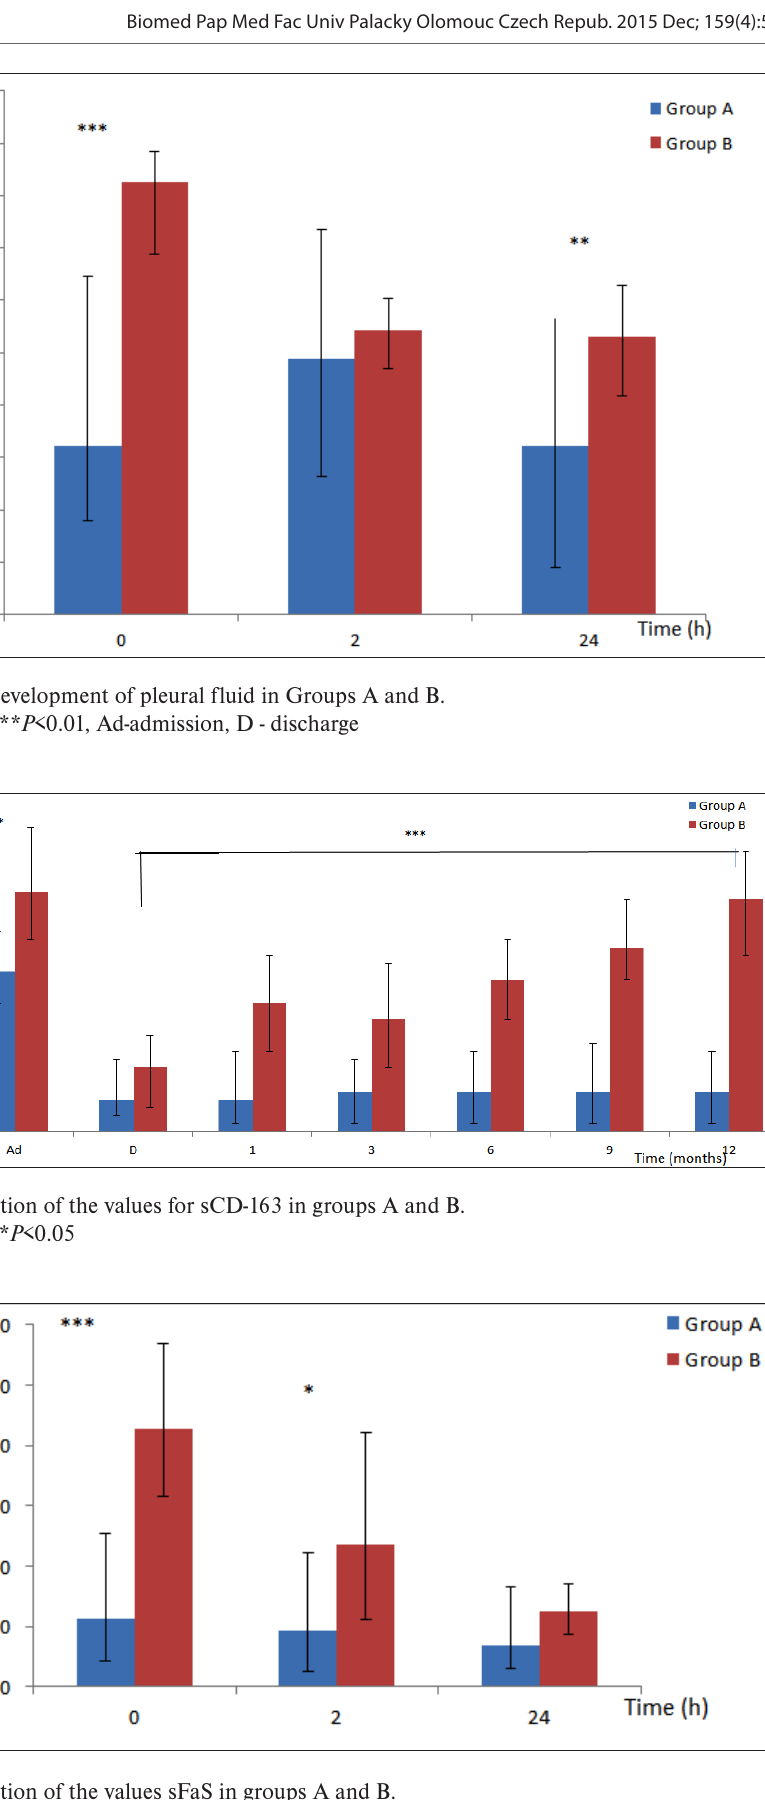
Fig. 3. Evolution of the values sFaS in groups A and B. *** P <0.001, ** P